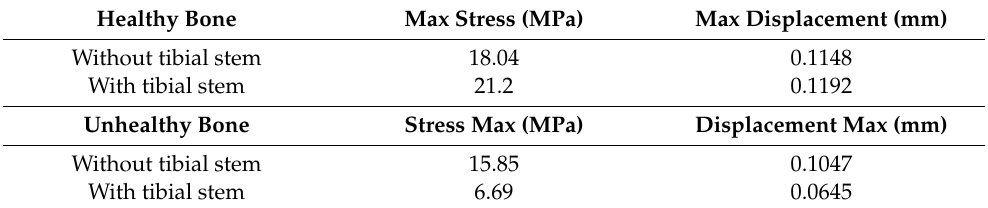
Table 3. Stress and displacement values in the static compression regime.